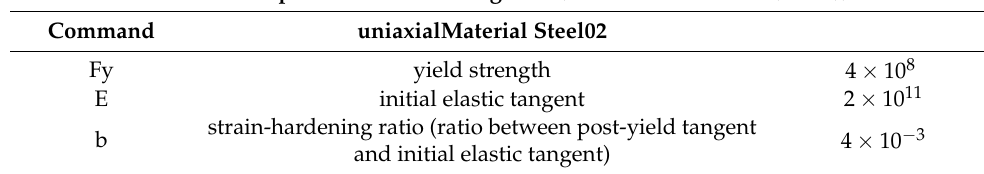
Table 4. Steel bars material properties.